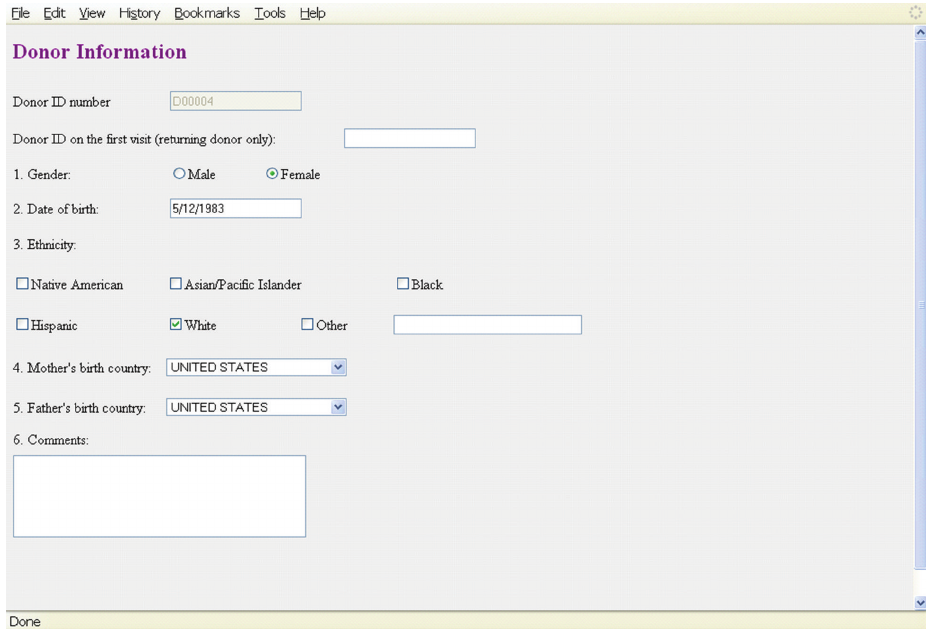
Figure 3: DONORDB: demographic information. The Figure displays a screen shot of the form used during initial enrollment of a donor.